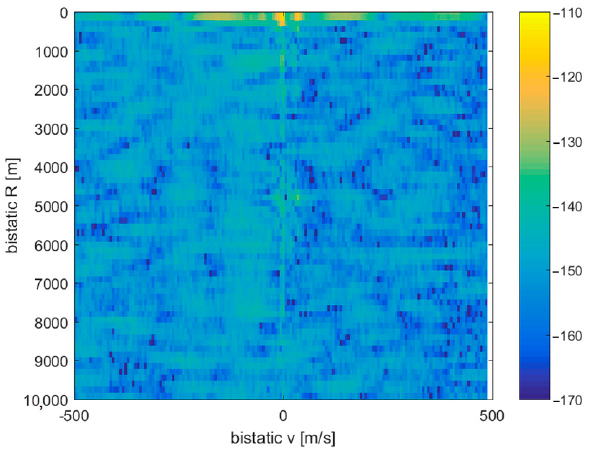
Figure 10. Sudden flash effect caused by the interference from an injected training signal. Clutter Structure Variations In moving PCL platforms, the residual clutter structure and intensity change as the platform is moving and changing its orientation [18–21]. In Figure 11, we can see that the ship is turning over a port, which changes the direction of the antenna array with respect to the illuminating transmitter. This change entailed a drop in the clutter intensity by 15 dB (the same color scale is used on three plots). In all cases, only the direct leakage signal was removed by an adaptive lattice clutter canceler [22] with the length of filtration truncated to the first two range cells.